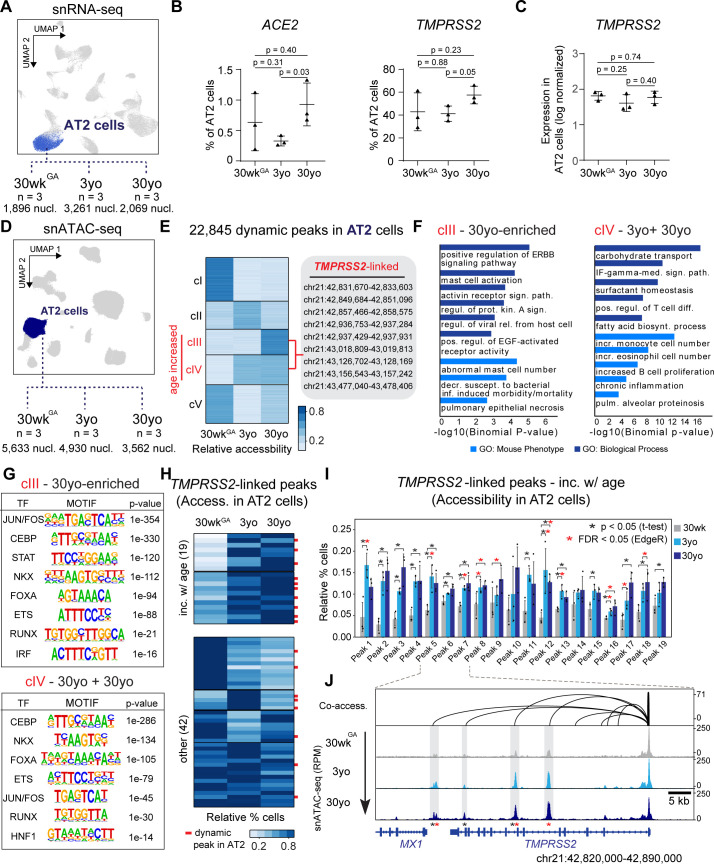
Age-increasing gene expression and accessible chromatin in AT2 cells exhibits signatures of immune regulation and harbors TMPRSS2-linked sites of chromatin accessibility.(A) Differential analysis was performed on AT2 cells between three ages with replicates (n = 3 per stage). (B) Fraction of AT2 cells with expression of ACE2 (left) and TMPRSS2 (right) in 30wkGA, 3yo and 30yo human lung samples. All data are represented as mean ± SD. p values derived from unpaired, two-tailed t-tests. For expression data of BSG, CTSL, FURIN please see Figure 3—figure supplement 1A. (C) Log normalized expression of TMPRSS2 in AT2 cells. Displayed are median expression values for AT2 cells in individual samples with at least 1 UMI (unique molecular identifier). (D) Differential analysis was performed on AT2 cells using pairwise comparisons between three ages with replicates (n = 3 per stage). (E) K-means cluster analysis (K = 5) of relative accessibility scores (see Materials and methods) for 22,845 age-dynamic peaks (FDR < 0.05, EdgeR) (Robinson et al., 2010) in AT2 cells. Clusters III and IV show increasing accessibility with age and contain nine TMPRSS2-co-accessible sites. (F) GREAT (McLean et al., 2010) analysis of elements in group cIII (left panel) and cIV (right panel) shows enrichment of immune-related gene ontology terms. (G) Transcription factor motif enrichment analysis of elements in cIII and cIV. (H) K-means cluster analysis (K = 6) of TMPRSS2-co-accessible sites based on the relative percentage of AT2 cells with at least one fragment overlapping each peak. Red bars indicate dynamic peaks identified from pair-wise differential analysis (FDR < 0.05, EdgeR) (Robinson et al., 2010). (I) Locus restricted differential analysis of TMPRSS2-linked peaks with increased accessibility in AT2 with age (top panel in 3H). Data are represented as mean ± SD. Black asterisk, p<0.05 (independent t-test); Red asterisk, FDR < 0.05 (EdgeR) (Robinson et al., 2010) from dynamic peak analysis. For additional sites and promoter accessibility of TMPRSS2 please see Figure 3—figure supplement 1B,C. (J) Genome browser representation of four TMPRSS2-linked peaks across age groups (Robinson et al., 2011).Figure 3—source data 1.Normalized expression values for TMPRSS2 in AT2 cells.